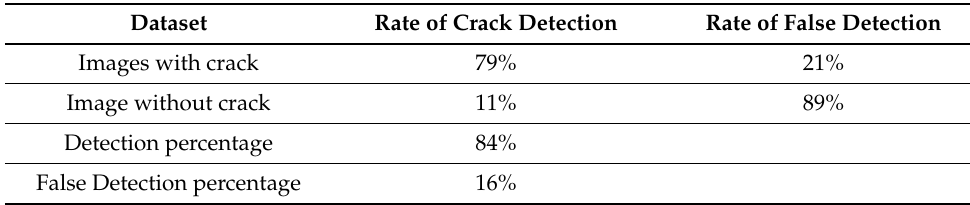
Figure 18. Crack detection system. Table 3. Results obtained on sets of images with or without cracks.